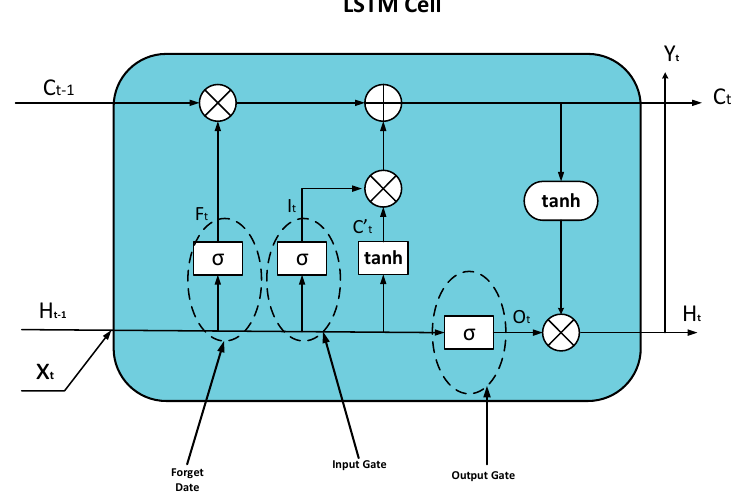
Figure 8. Internal structure of LSTM.